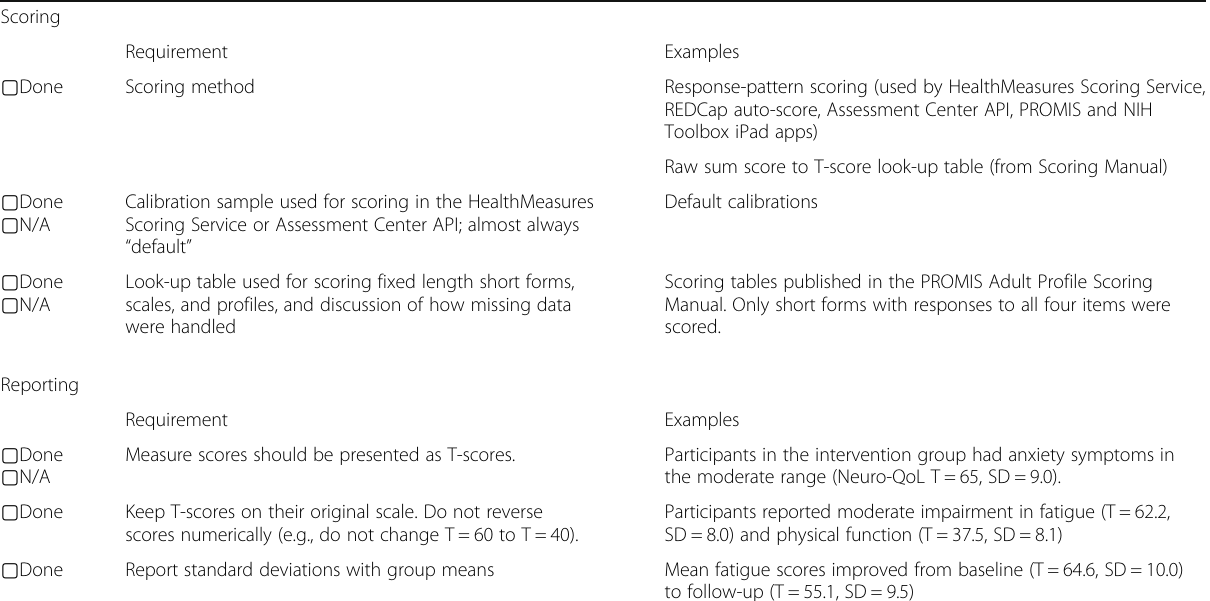
Table 1 Reporting checklist for ASCQ-Me, Neuro-QoL, NIH Toolbox Emotion, and PROMIS (Continued)